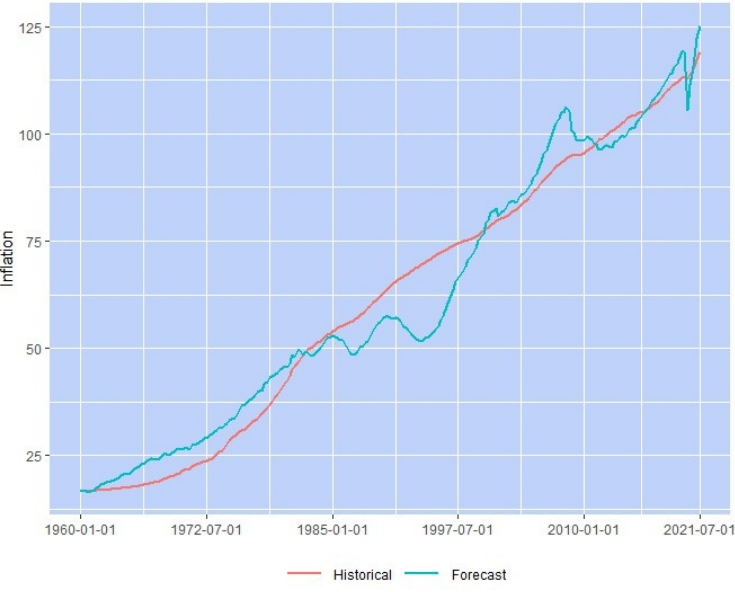
Figure 2. Inflation as a function of money stock and velocity, excluding GDP. Table 6. Inflation estimation, without GDP as independent